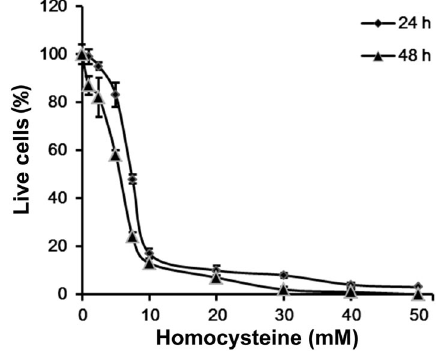
Figure 1. Neuro2a cells were incubated with 10 – 50 mM homo- cysteine (Hcy) for 24 or 48 h. Cell viability was assessed with the WST-8 Cell Counting Kit-8 (Dojindo, Japan).